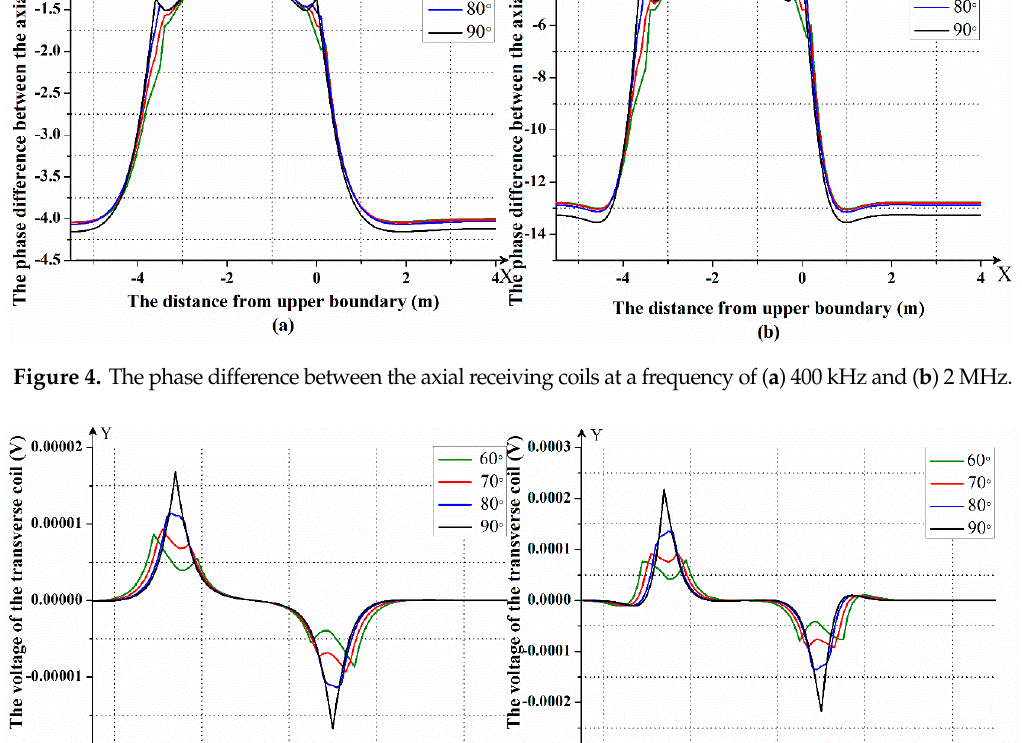
Sensors 2019 , 19 , x FOR PEER REVIEW 9 of 14